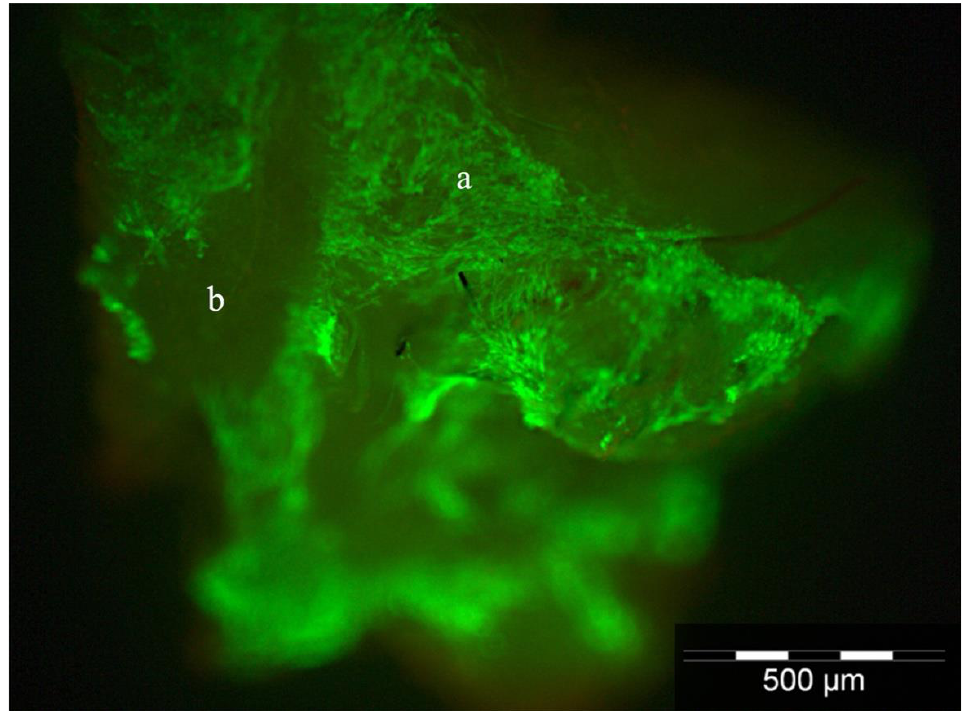
Figure 2. Visualization of cell viability and attachment of C2C12 myofibroblast cells (a) on the spider silk scaffold by LIVE/DEAD ® staining. (b) Marks the fibers of the auto-fluorescent spider silk.